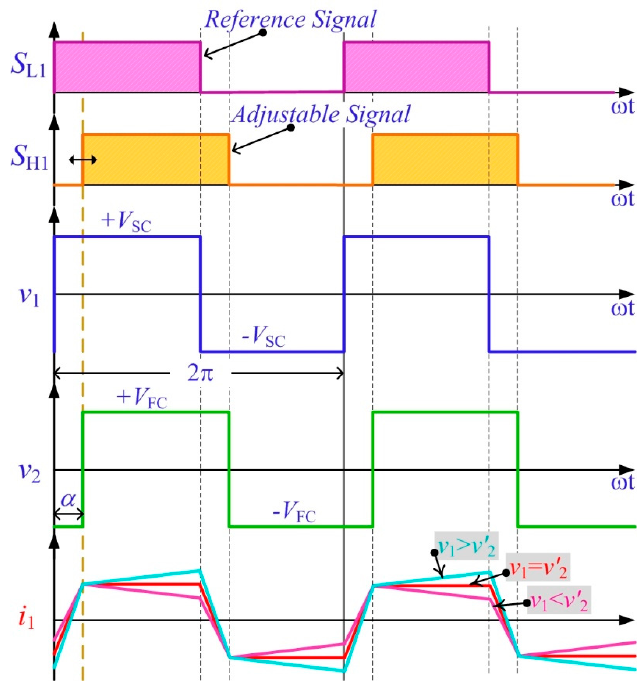
Figure 9. Ideal operating waveforms of the two-port converter at α > 0 ( p SC > 0).